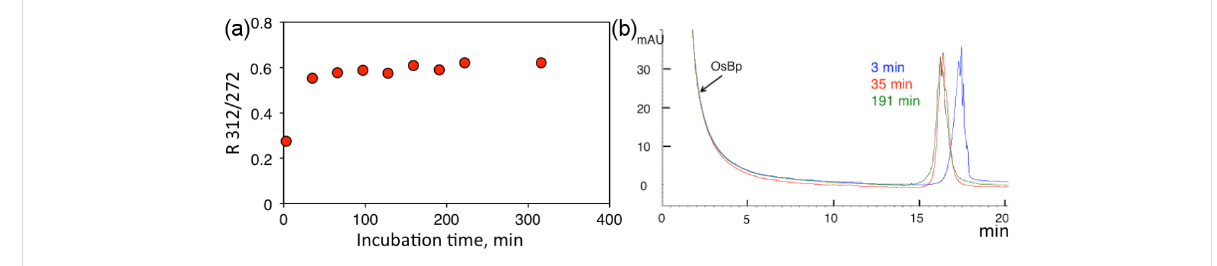
Figure 1: (a) Reactivity profile of a 32-mer deoxyoligo, pGEX3’-A 9 , in aqueous 12.6 mM OsBp at 25 °C monitored automatically by HPLC (see oligo sequence in Table 1). Practically complete osmylation is observed after 40 min. It is noticeable that the peak area of the oligo does not show major changes at 260 nm (shown), or at 272 nm. However, the absorbance at 312 nm starts at 0 and increases with extent of osmylation; R minimizes instrument sampling errors. (b) HPLC profiles at 260 nm for selected analyses. The OsBp peak is very large but elutes early and does not interfere with the oligo peak. Because this oligo has 9 pyrimidines, osmylation results in multiple isomers that elute closely together as a broad peak. Neverthe- less, the more extensive the osmylation, the earlier the retention time (rt) [30]; this is why there is a rt difference between the profiles at 3 min and